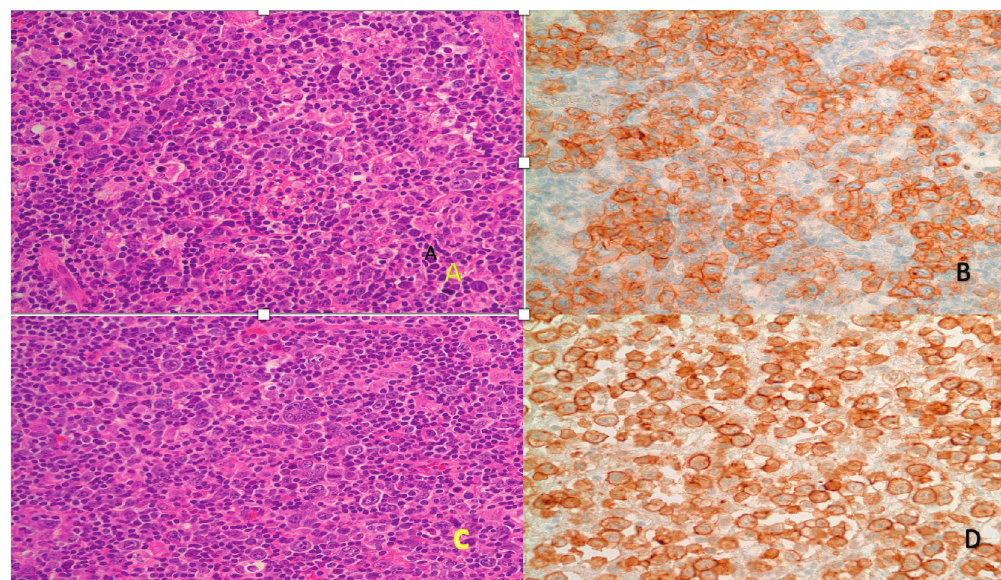
Figure 1: (a) HL intrasinusoidal infiltrate. H&E x400. (b) HL. CD30 stain x400. (c) ALCL intrasinusoidal infiltrate. H&E x400. (d) ALCL.